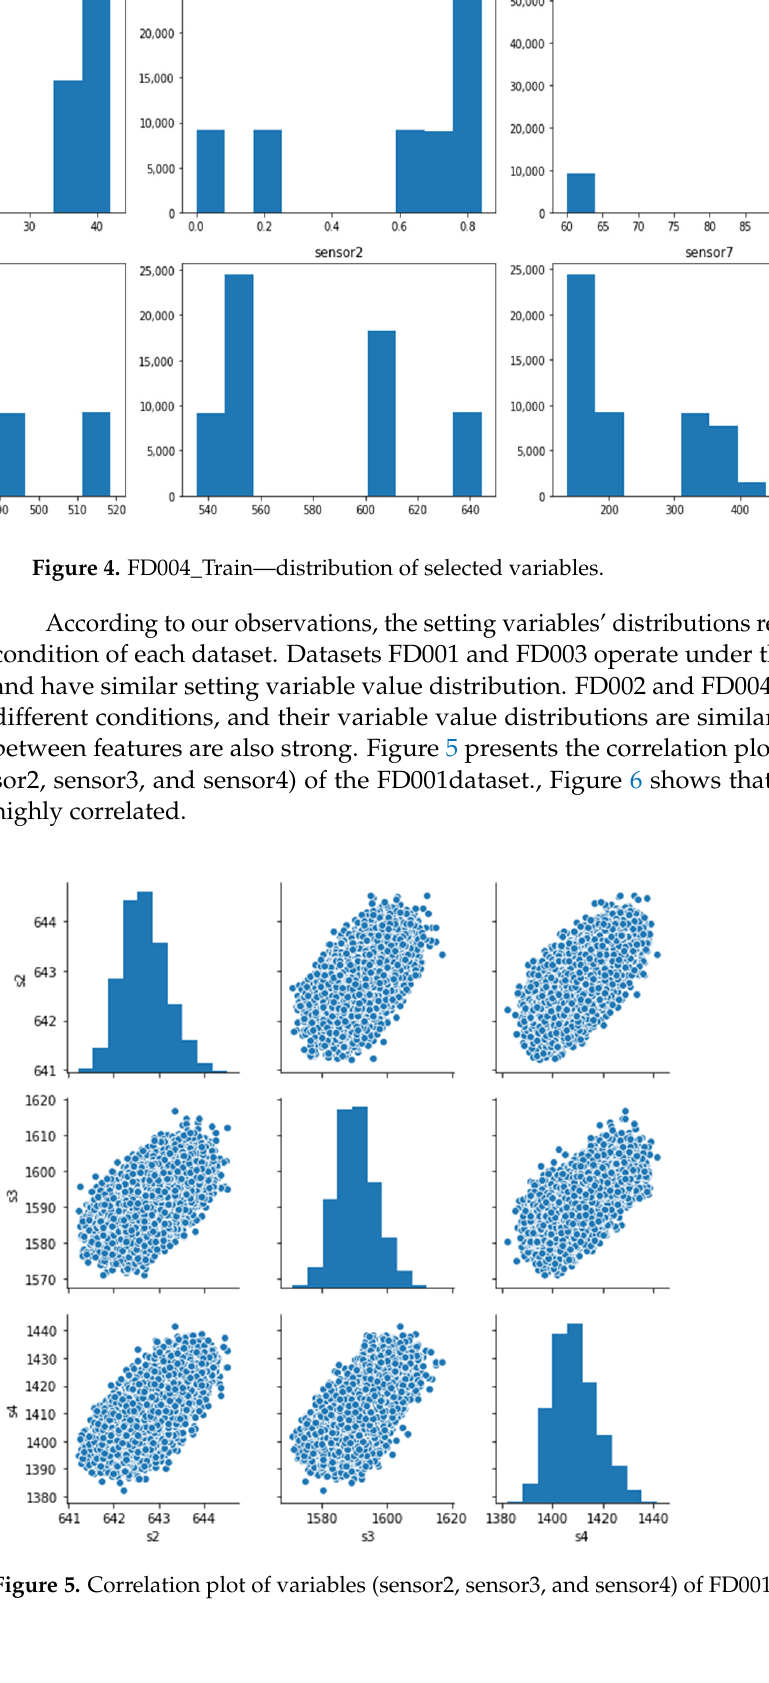
Figure 3. FD003_Train—distribution of selected variables.